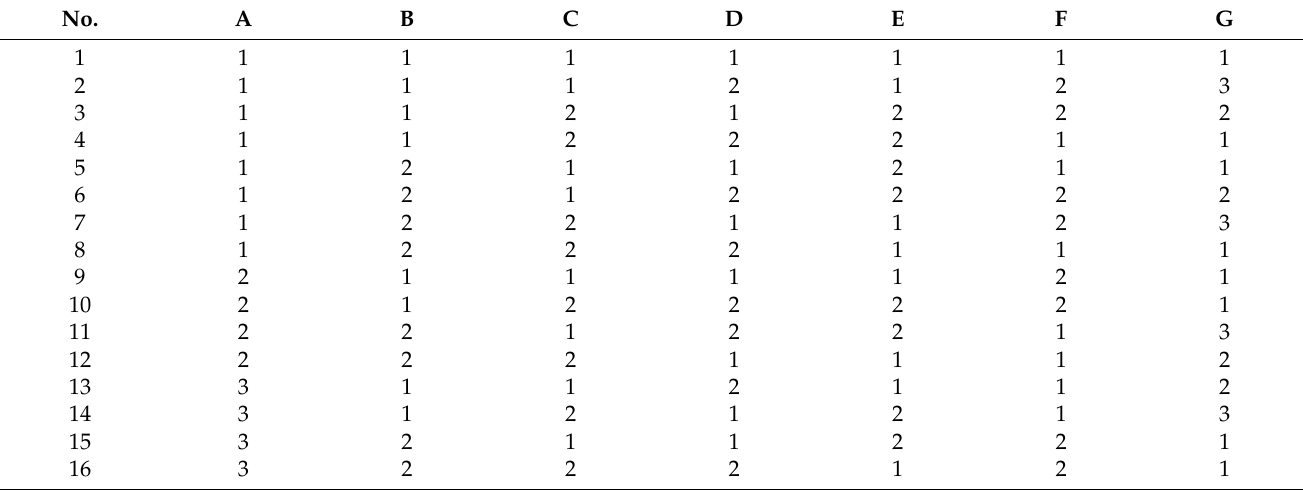
Table 3. Orthogonal design of the SP questionnaire.